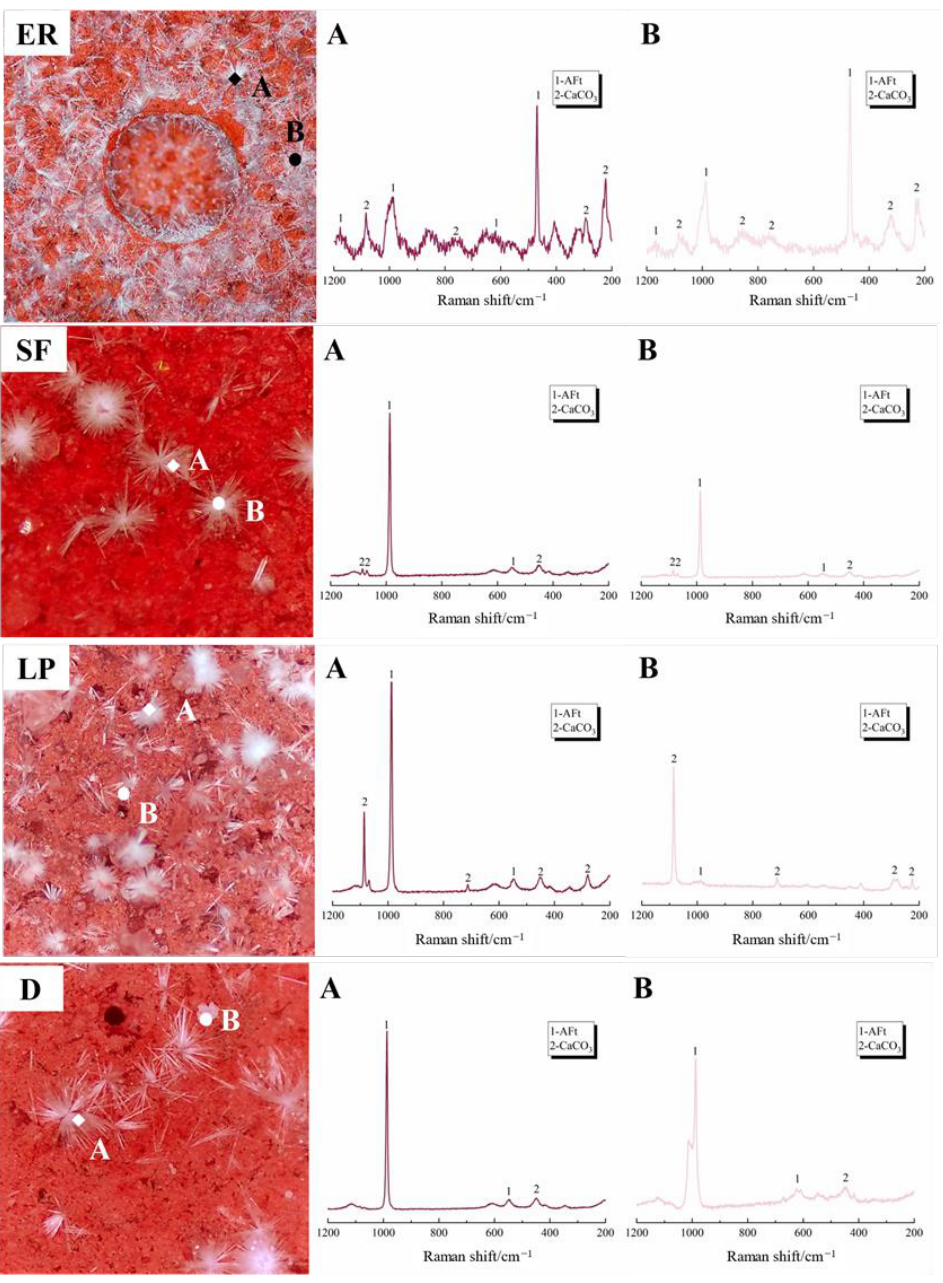
Figure 5. Raman spectrum of efflorescence substances on cement